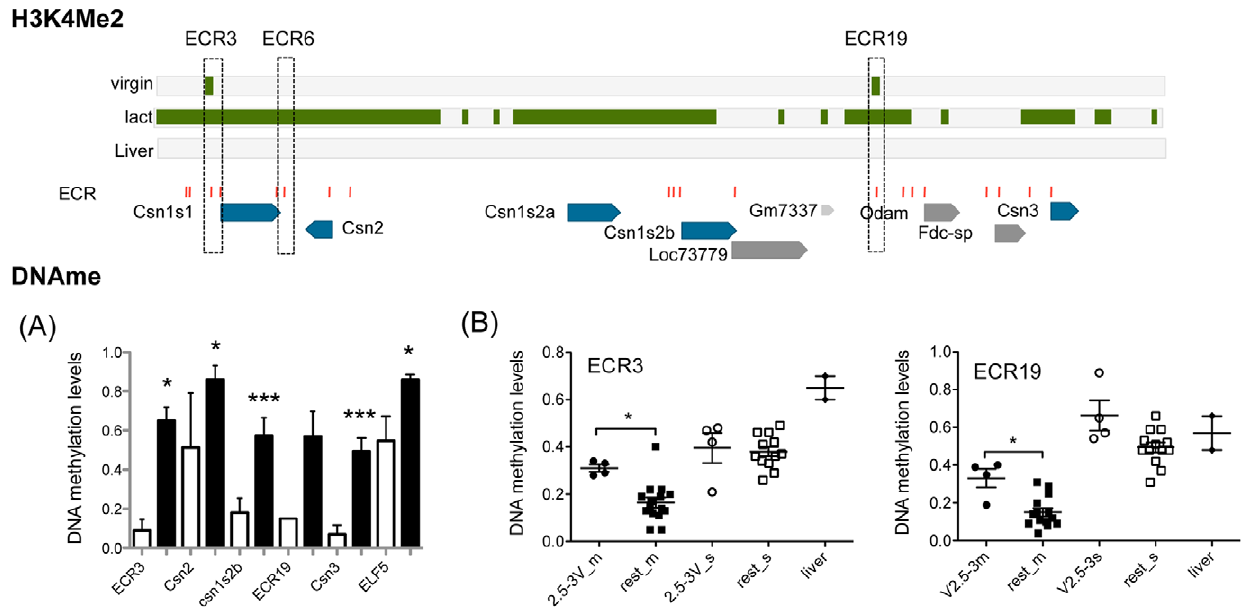
Figure 5. Tissue-specific DNA methylation, and DNA methylation for ECR3 and 19 during mammary gland development. Top panel: Summary of H3K4me2 levels, ECR and gene locations in the CSN region (based on Figure 2). ( A ) Tissue specific DNA methylation levels: DNA methylation levels in lactating mammary gland (white bars) and liver tissue (black bars). Significance was determined using an un-paired, 2-tailed t- test: * , 0.05, *** , 0.0001. For ECR3 (MG, n=2; Liver n=2) and ECR19 (MG: n=1; Liver n=2) MeCpG percentages were determined with SEQUENOM mass-array technology (see table S2). Beta-casein promoter (Csn2) (MG, n=5; Liver n=5), Alpha-s2b casein promoter (Csn1s2b) (MG, n=5; Liver n=5), and Kappa casein promoter (Csn3) (MG, n=4; Liver n=4), were determined by bisulfite-sequencing (See Fig. 6 for details). ( B ) DNA methylation levels during mammary gland development and differentiation. MeCpG levels for ECR3 (average of 5 CpG sites in 561 bp) and ECR19 (average of 6 CpG sites in 599 bp) were determined with SEQUENOM mass-array technology (see table S2), different developmental time points are depicted with different symbols, each symbol represents an independent MEC or non-MEC prep from pooled tissue samples (see MEC prep) for virgin samples, 7day pregnant, INV and AMV, or individual animal (16 day pregnant and 8day lactating). Mammary epithelium (filled symbols ) Pre-pubertal, filled circles (2.5-3V_m: 2.5–3 week old virgin females); Post-pubertal, filled square (rest_m: 3.5–4 week old virgins; 5.5–6 week old virgin females; 8–15 week old virgins; 7day pregnant females; 16 days pregnant; 8 day lactation; Inv ( . 28 day after lactation); Age Matched Virgin (Virgin animals same age as . 28 day involuted animals) . Non-MEC cell fraction of the mammary gland (open symbols ): pre-pubertal: 2.5-3V_s, open circles: 2.5–3 week old virgin females; post-pubertal: rest_s (3.5–4 week old virgin females; 5.5–6 week old virgins; 8–15 Week old virgins; 7day pregnant females; Inv ( . 28 day after lactation); Age Matched Virgin (Virgin animals same age as . 28 day involuted animals). Liver tissue : filled diamond. ECR3 (Fig. 2). In addition, we detected a DHS at ECR19 in 8